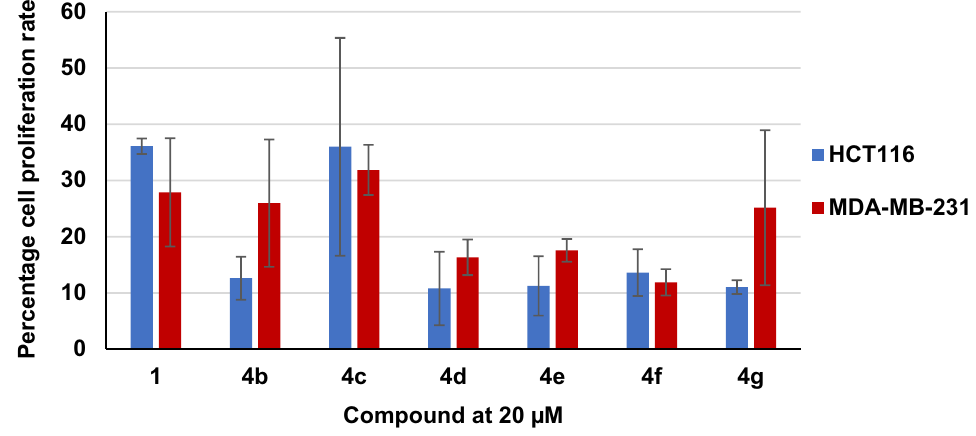
Figure 2. Cell proliferation rate (%) of HCT116 ad MDA-MB-231 cancer cell lines treated with compounds (20 µM), in comparison to 100% proliferation rate when cells were treated with